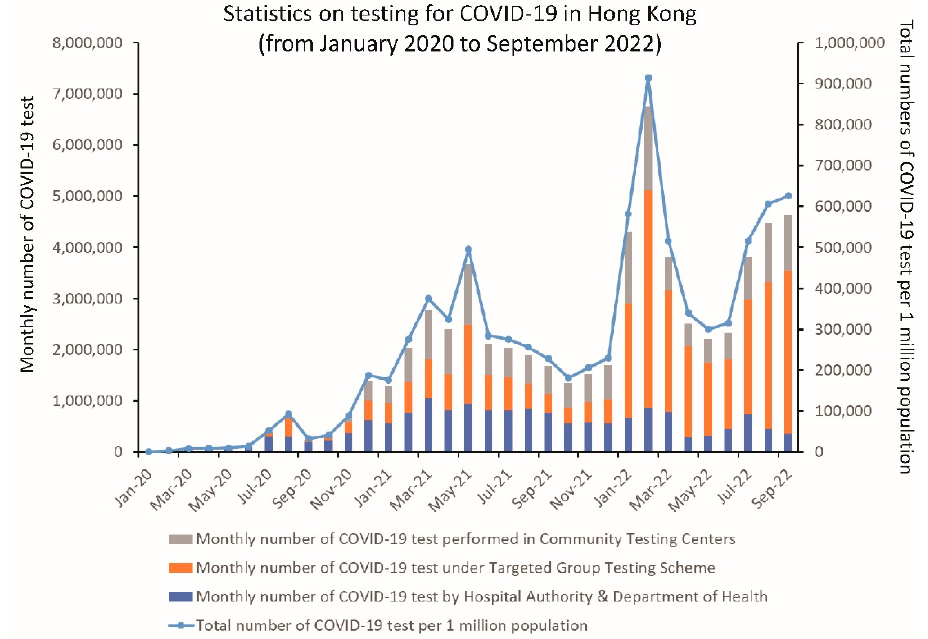
Figure 7. The number of COVID-19 tests under different categories of requests. Community testing centers provided self-paid services (from 15 November 2020, day 321) and free testing for persons under compulsory testing (from 22 November 2020, day 328). The Targeted Group Testing Scheme refers to essential staff providing services to critical infrastructure (from 14 July 2020, day 197). The Hospital Authority and Department of Health were responsible for testing hospitalized patients and out-patients during the COVID-19